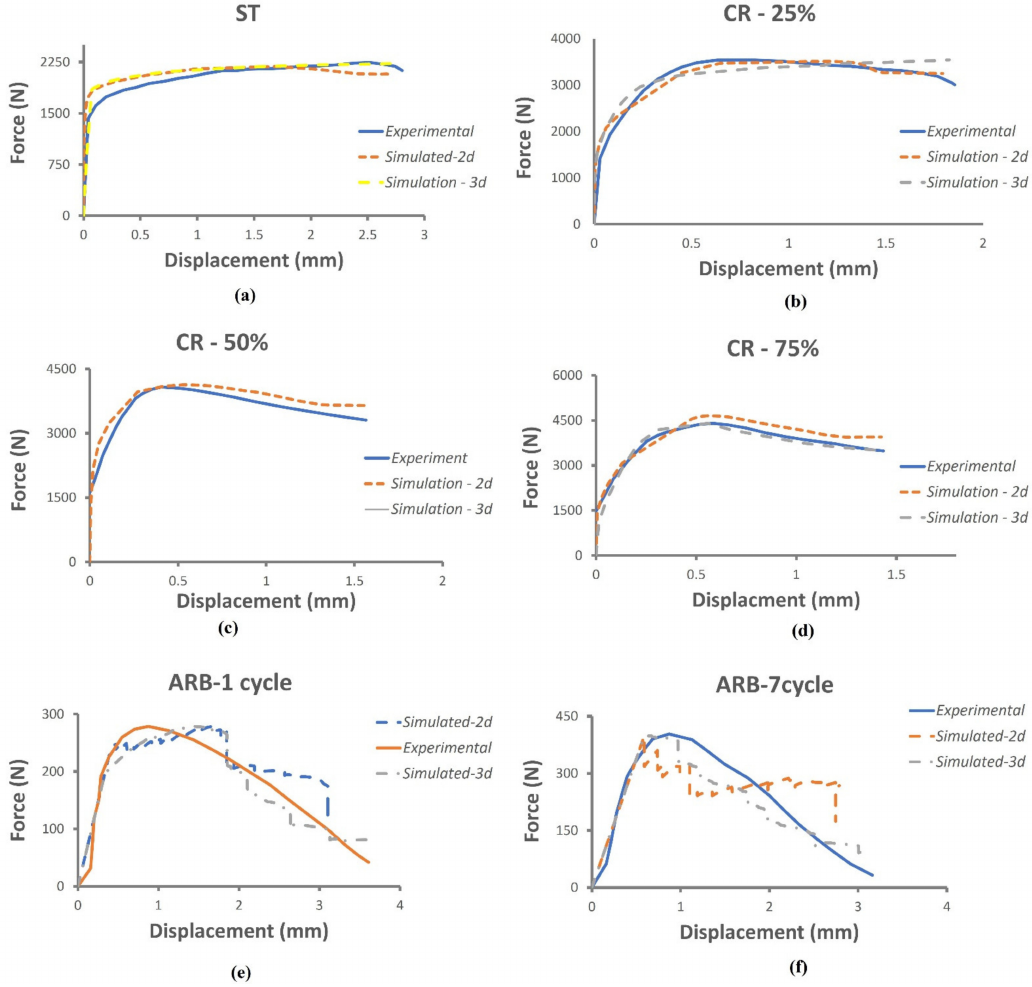
Figure 12. Comparison of experimental and simulated results in ( a ) ST ( b ) CR-25 ( c ) CR-50 ( d ) CR-75 ( e ) ARB-1 cycle ( f ) ARB-7